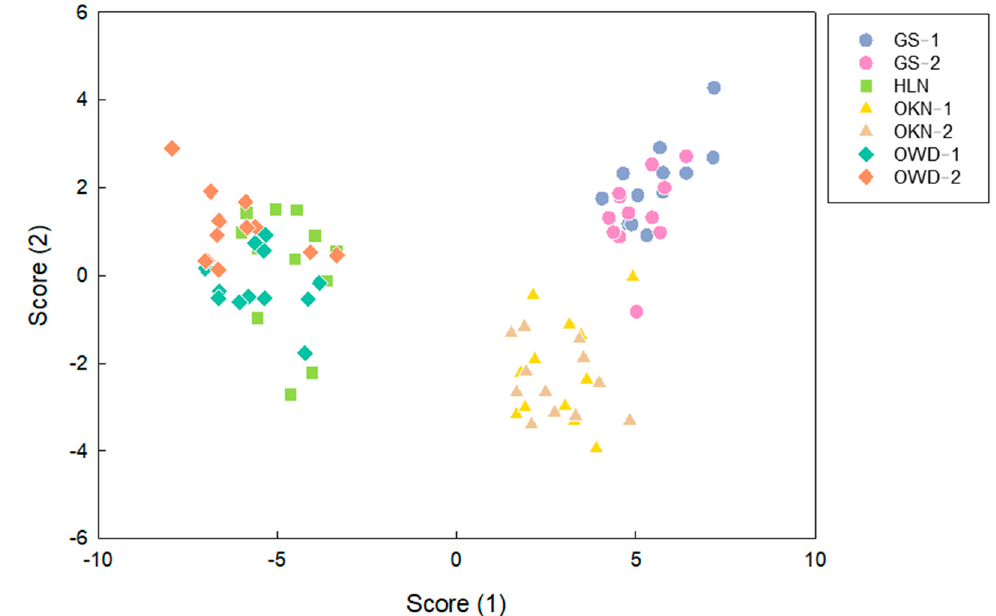
Figure 7. The canonical scores plot of LDA by volatile compositions in Citrus depressa varieties. Each spot represents each analytical replicate. Blue dots (GS-1) and purple dots (GS-2) represent the original sample trees in germplasm; green square (HLN) represents the scion from Hualien; yellow triangle (OKN-1) and brown triangle (OKN-2) are the scion of Okinawa; cyan diamond (OWD-1) and orange diamond (OWD-2) represent the scions collected from Ouwanda.